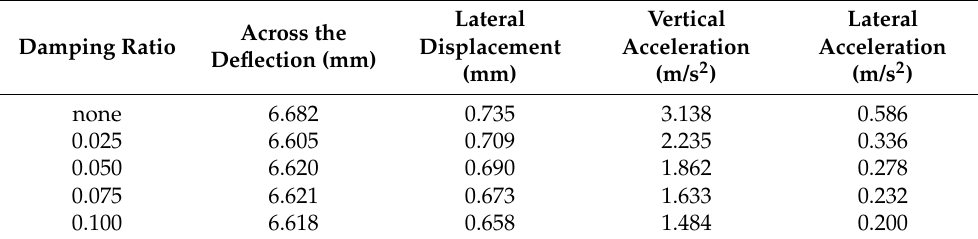
Table 12. Maximum response in lower span with a different damping ratio.